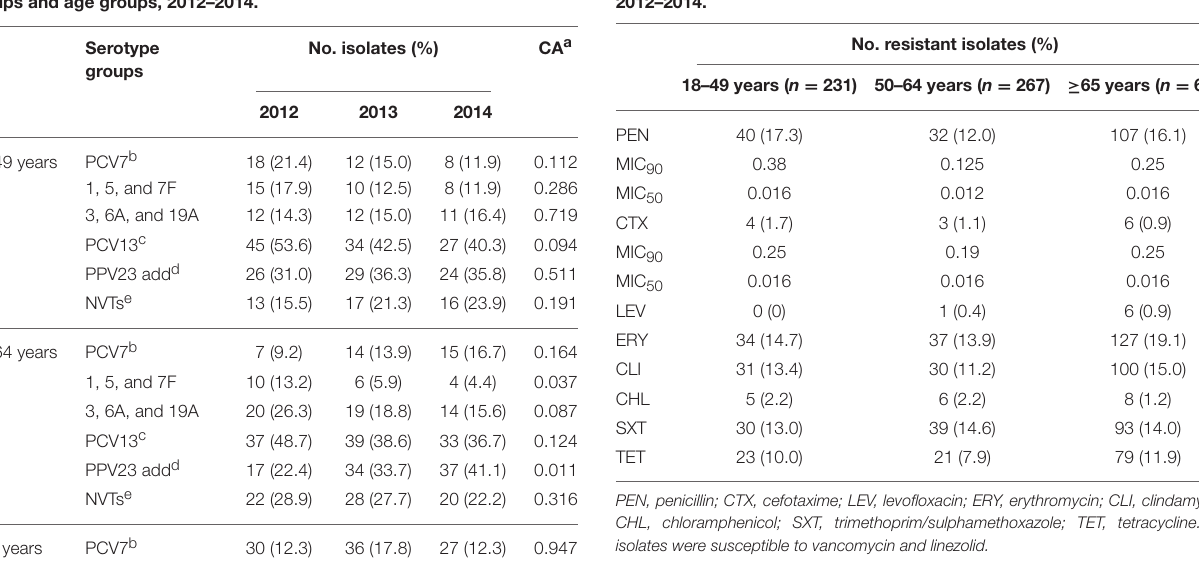
TABLE 2 | Number of isolates responsible for invasive pneumococcal disease in adult patients ( ≥ 18 years), according to vaccine serotype groups and age groups, 2012–2014.